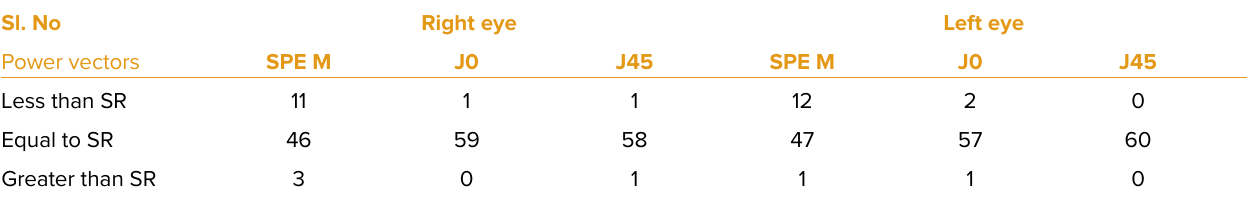
Table 1. Comparison of AHAR and SR measurements.